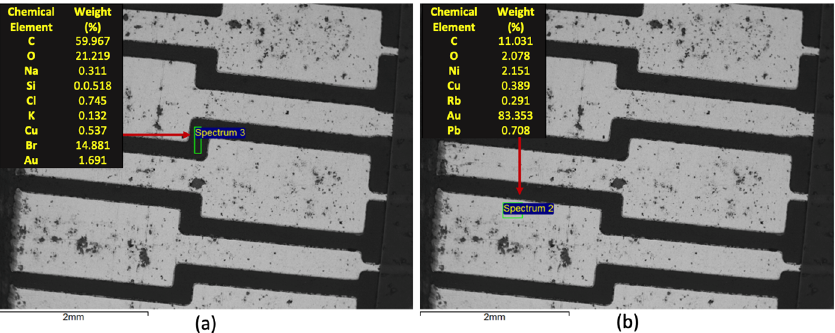
Figure 3. SEM/EDS characterization of Type 1 WEEE sample: ( a ) microanalysis of the dark area; ( b ) microanalysis of the bright area.